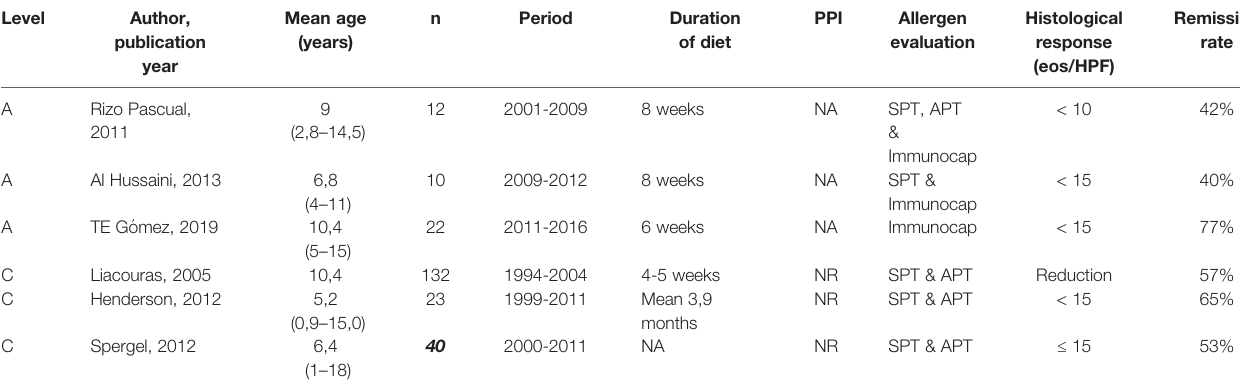
TABLE 3 | Overview of studies on the allergy test-directed elimination